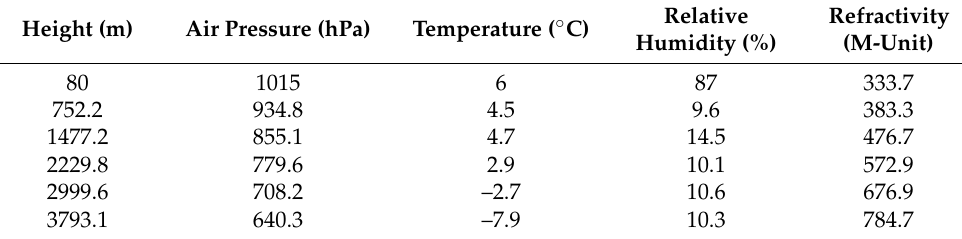
Figure 1. Airborne radar wave propagation for TDP in accordance with anomalous atmospheric environment. Table 1. Modified refractive index based on measured data (3 January 2017).